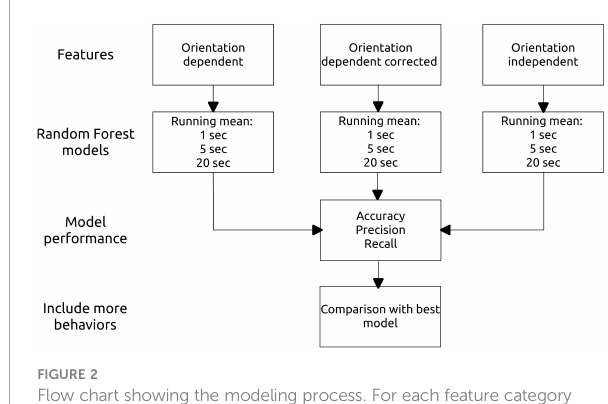
FIGURE 2 Flow chart showing the modeling process. For each feature category (orientation dependent, orientation dependent corrected, orientation independent), we ran three models, one for each running mean (1, 5, and 20 seconds). Furthermore, after assessing the models performance we reran the best model including more